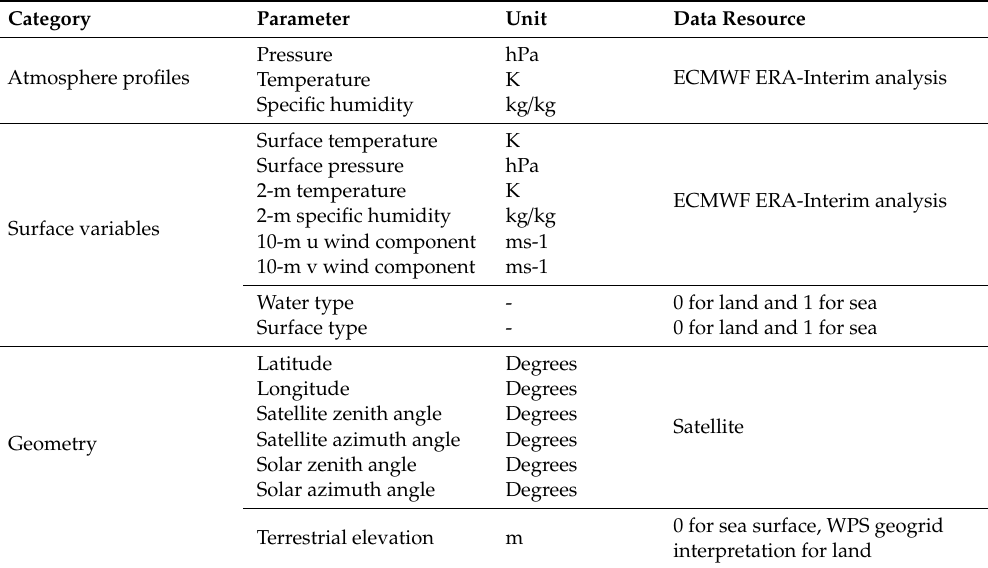
Table 2. Input variables and parameters for clear-sky simulations with RTTOV 12.2.